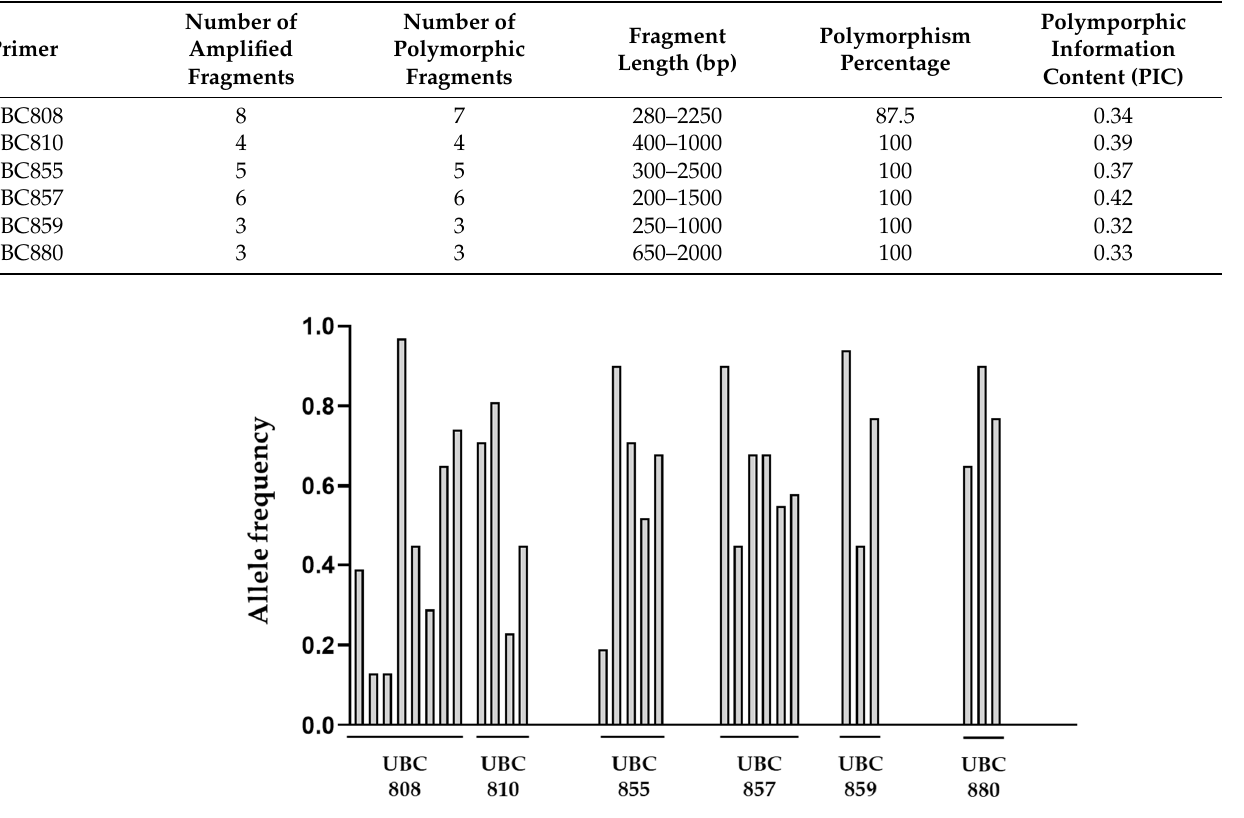
Figure 2. Allele number and frequency for all six ISSR primers.